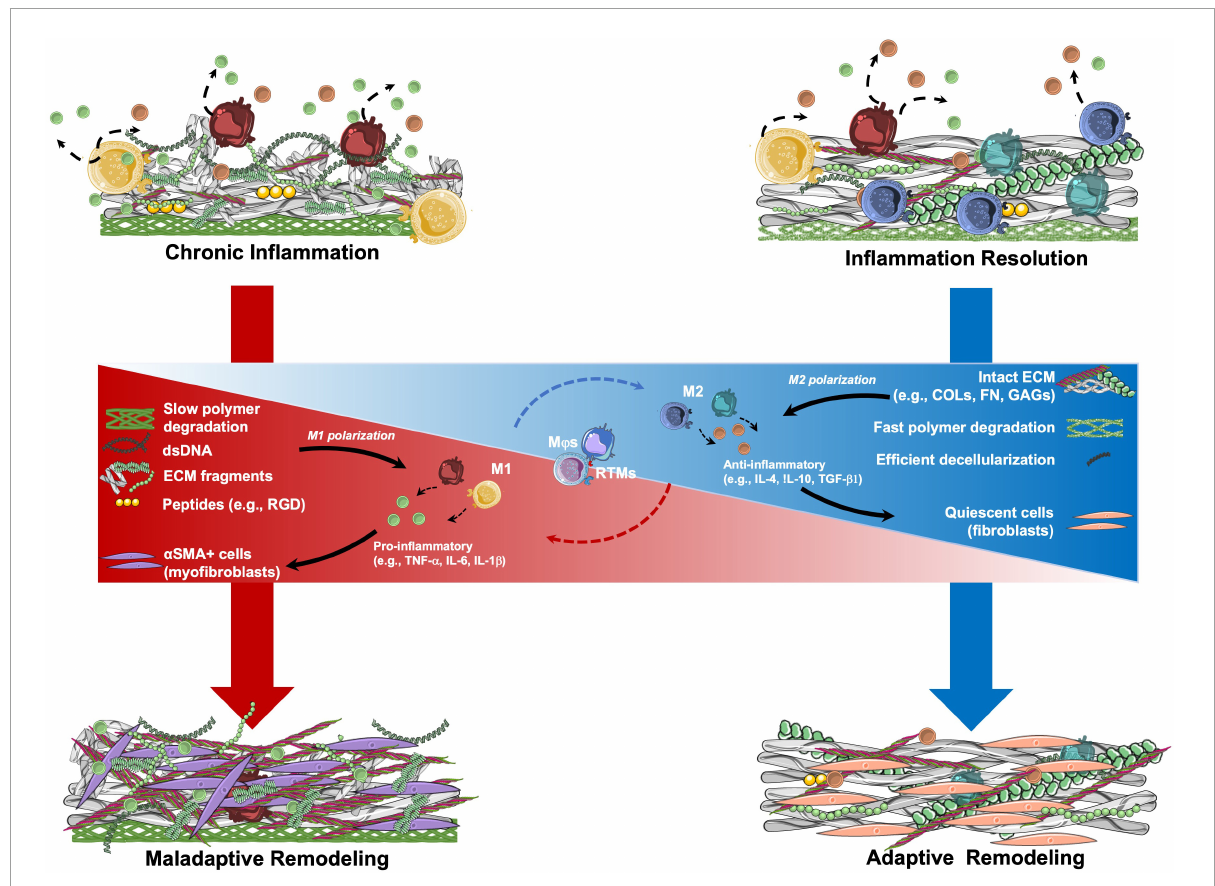
FIGURE3 Hypothetical mechanisms involved in the remodeling of tissue engineered matrix (TEM)-based implants. TEM composition may be a crucial parameter in determining the remodeling potential of TEM-based implants. Resident tissue macrophages (RTMs) and circulation-derived macrophages (M ϕ s) are key mediators of the inflammatory process. Once in contact with TEMs, RTMs and M ϕ s may start a pro- or anti-inflammatory signaling by polarizing between M1 and M2 states, respectively. The sustained presence of polymer remnants, ECM fragments, and double stranded DNA (dsDNA) residues from incomplete decellularization, may lead to pro-inflammatory stimulation of RTMs and M ϕ s with consequent M1 polarization with the release of pro-inflammatory factors. This pro-inflammatory state may lead to the activation of fibroblasts into myofibroblasts, with the consequent production of a collagen-rich ECM, similarly to what is observed in tissue fibrosis (maladaptive remodeling). In contrast, TEMs having intact ECM proteins (e.g., COLs, FN, GAGs) as well as low amounts of dsDNA after optimal decellularization, may determine a short pro-inflammatory phase followed by M1 polarization resolution and transition to the M2 state. M2 RTMs and M ϕ s may help with provisional matrix formation. Recruited fibroblasts populate the implant and produce organized ECM until resolution of the inflammation occurs (adaptive remodeling). α SMA, alpha smooth muscle actin; COLs, collagens; FN, fibronectin; GAGs, glycosaminoglycans; IL, interleukin; RGD, Arg-Gly-Asp; TGF, transforming growth factor; TNF, tissue necrosis